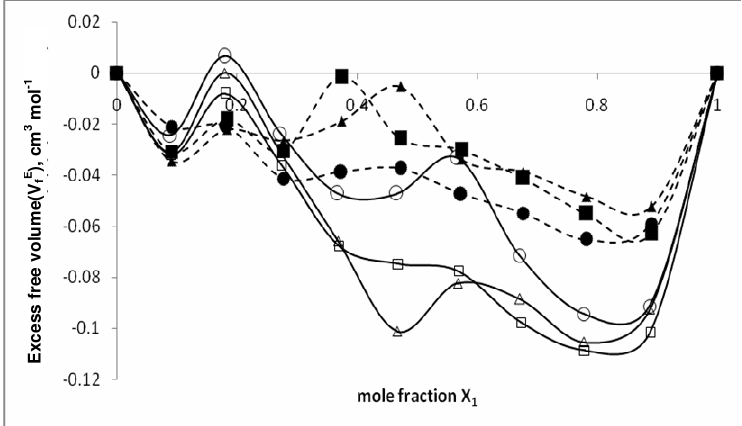
Figure 3. Excess free volume vs mole fraction of MMA for MMA + tert -butanol and MMA + iso